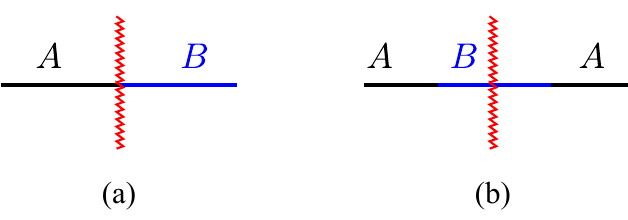
Figure 1 . Di(cid:11)erent set-ups for entanglement entropy. Figure (a) is the set-up of previous studies where the subsystem size goes to in(cid:12)nity and the defect is localized at one end of the subsystem. Figure (b) is our set-up where the subsystem is (cid:12)nite with length r and the defect is located within the